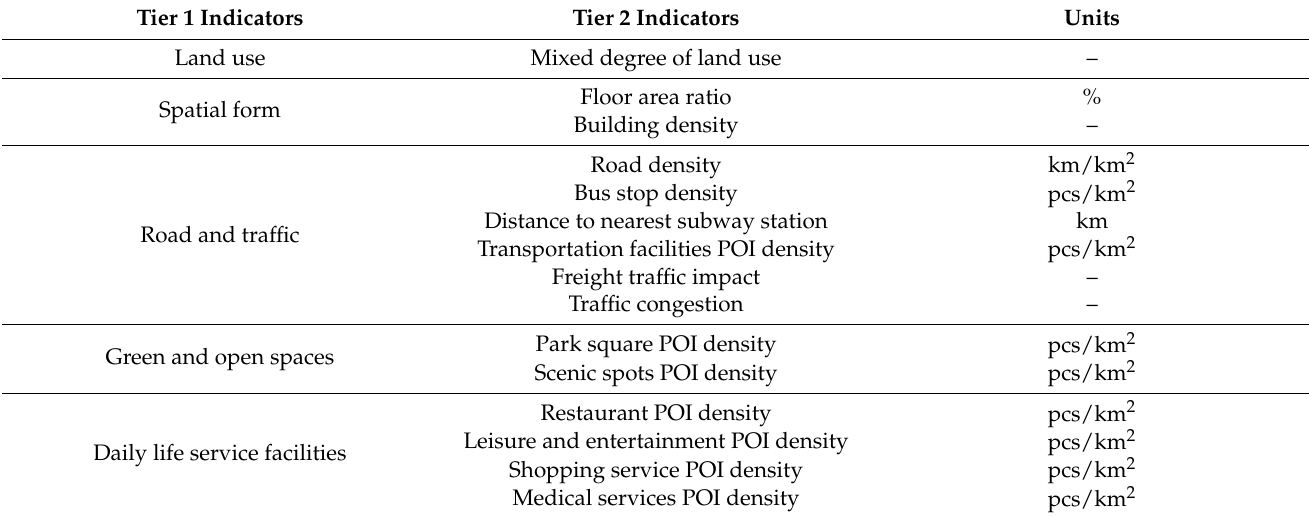
Table 5. Urban built environment measurement index system.